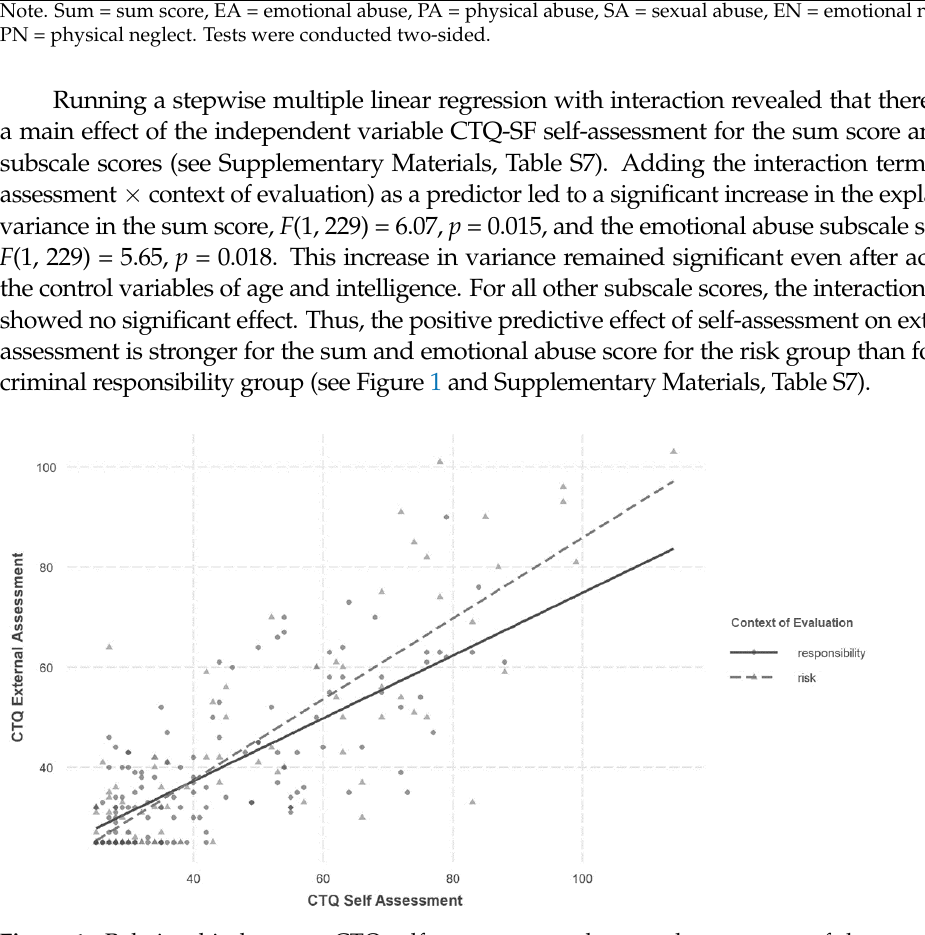
Figure 1. Relationship between CTQ self-assessment and external assessment of the sum score depending on the context of evaluation.